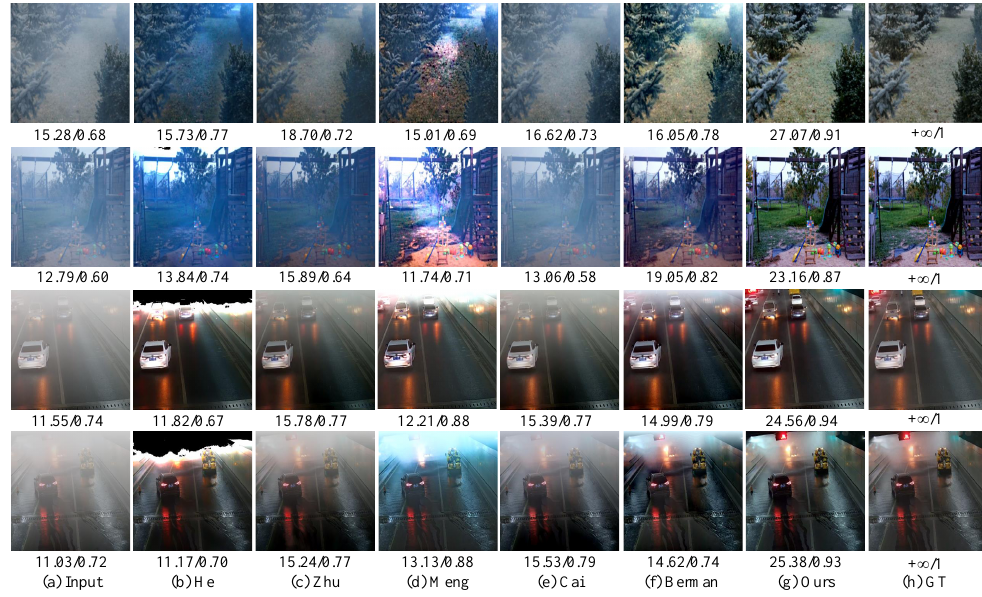
Figure 6. The performances of different image dehazing algorithms on synthetic outdoor